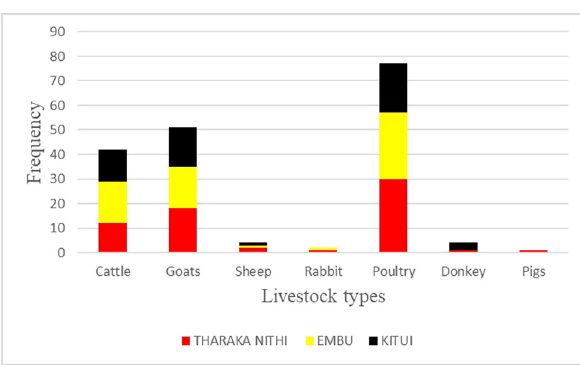
Figure 5: Livestock species reared in the selected counties of Eastern Kenya. Cattle, goats, and poultry were the dominant live - stock species across the three counties. The animals were predo - minantly kept for sustainable insurance in addition to crop farming. Proceeds from livestock sales were majorly used to pay for educa - tion and other daily household